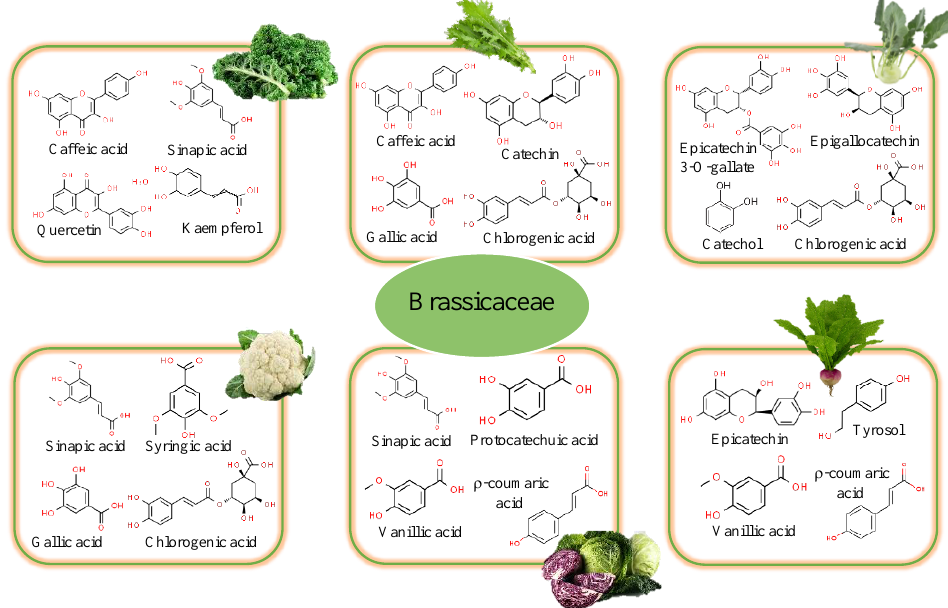
Figure 3. Main bioactive compounds responsible for Brassicaceae activity.